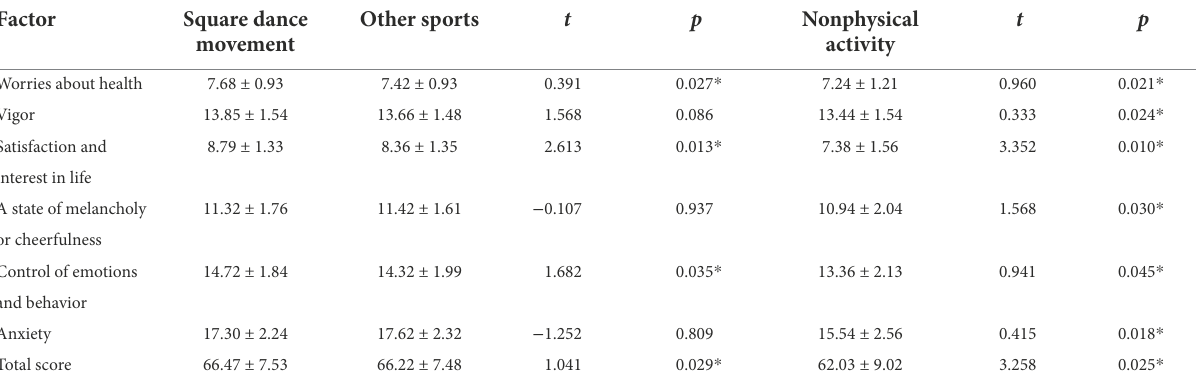
* Indicates a significant difference compared with square dancers, p <